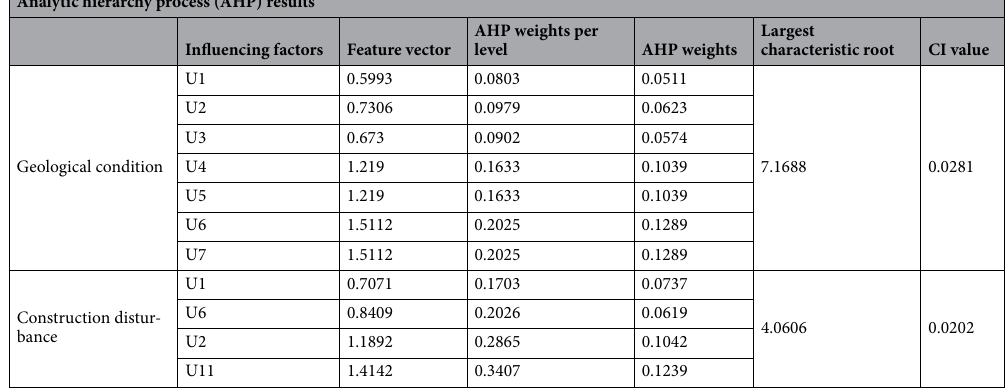
Table 10. AHP weights.